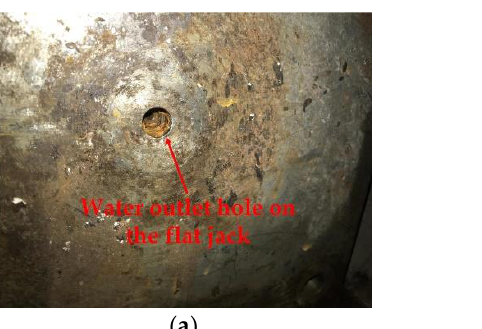
Figure 4. The true-triaxial hydraulic fracturing apparatus: ( a ) the water injection system; ( b ) the steel framework, confining pressure system, and the heating system; ( c ) the fracturing capsule.